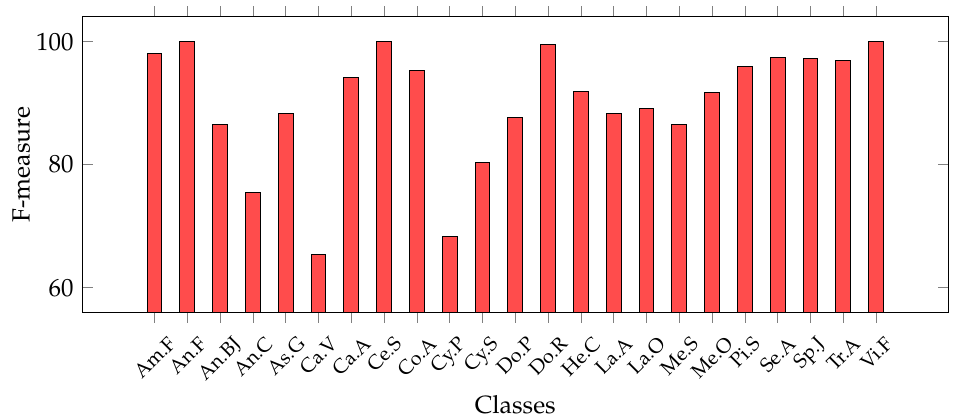
Figure 10. Classwise MFM on the best model for the Cagliari data set, trained with HC features: Ensemble trained with Shape + Texture + Colour (All)